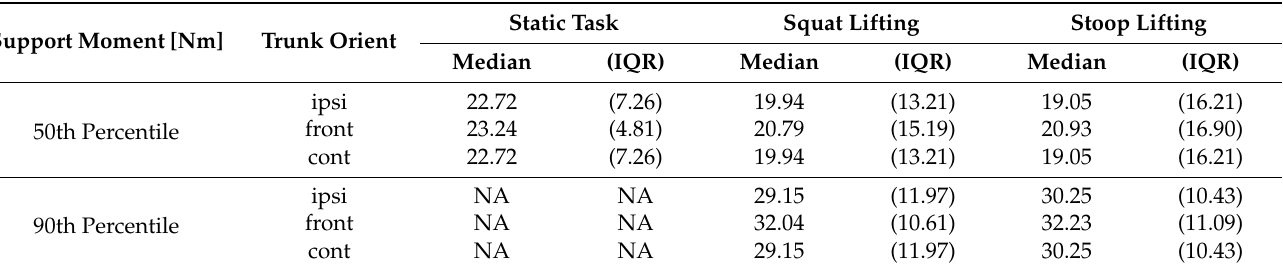
Table 4. Median values and corresponding interquartile ranges (IQR) showing the support moment provided by the